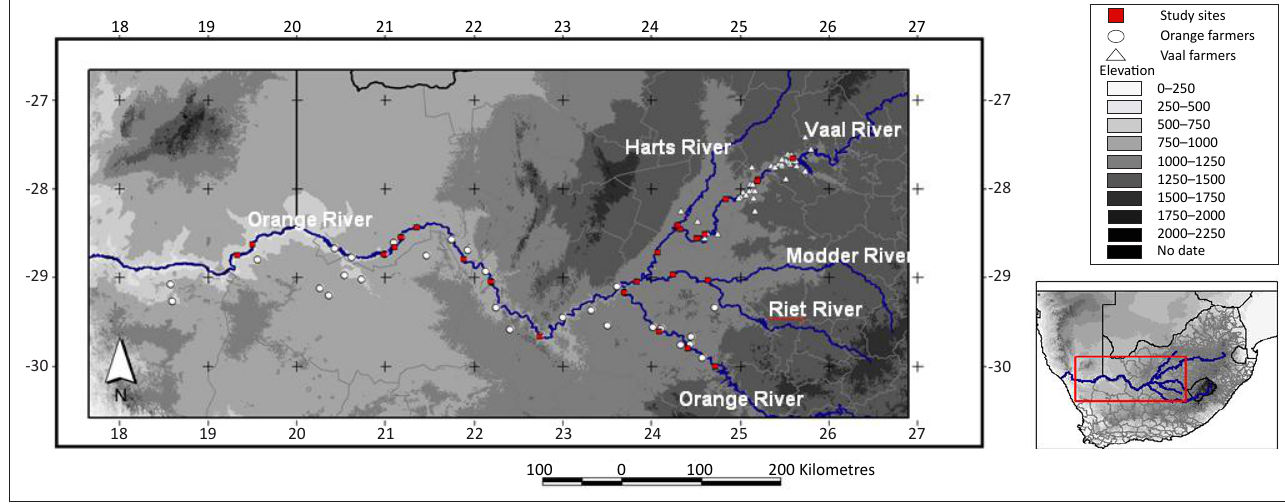
FIGURE 1: Study sites on the Orange, Vaal, Riet, Modder and Harts Rivers, as well as the locations of the livestock farmers that were contacted through